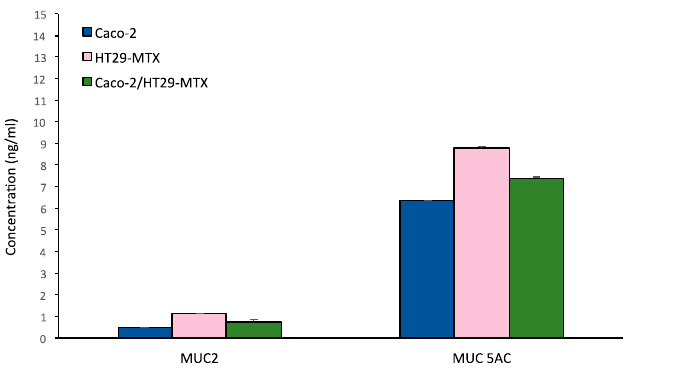
Figure 10. MUC 2 and MUC 5 AC mucins release in Caco-2 monoculture, HT29-MTX monoculture and Caco-2/HT29-MTX co-culture.